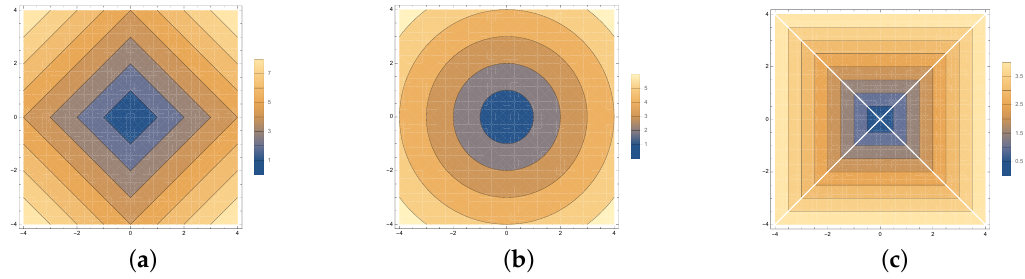
Figure 2. Examples of implicit functions: ( a ) l 1 , ( b ) l 2 , and ( c ) l ∞